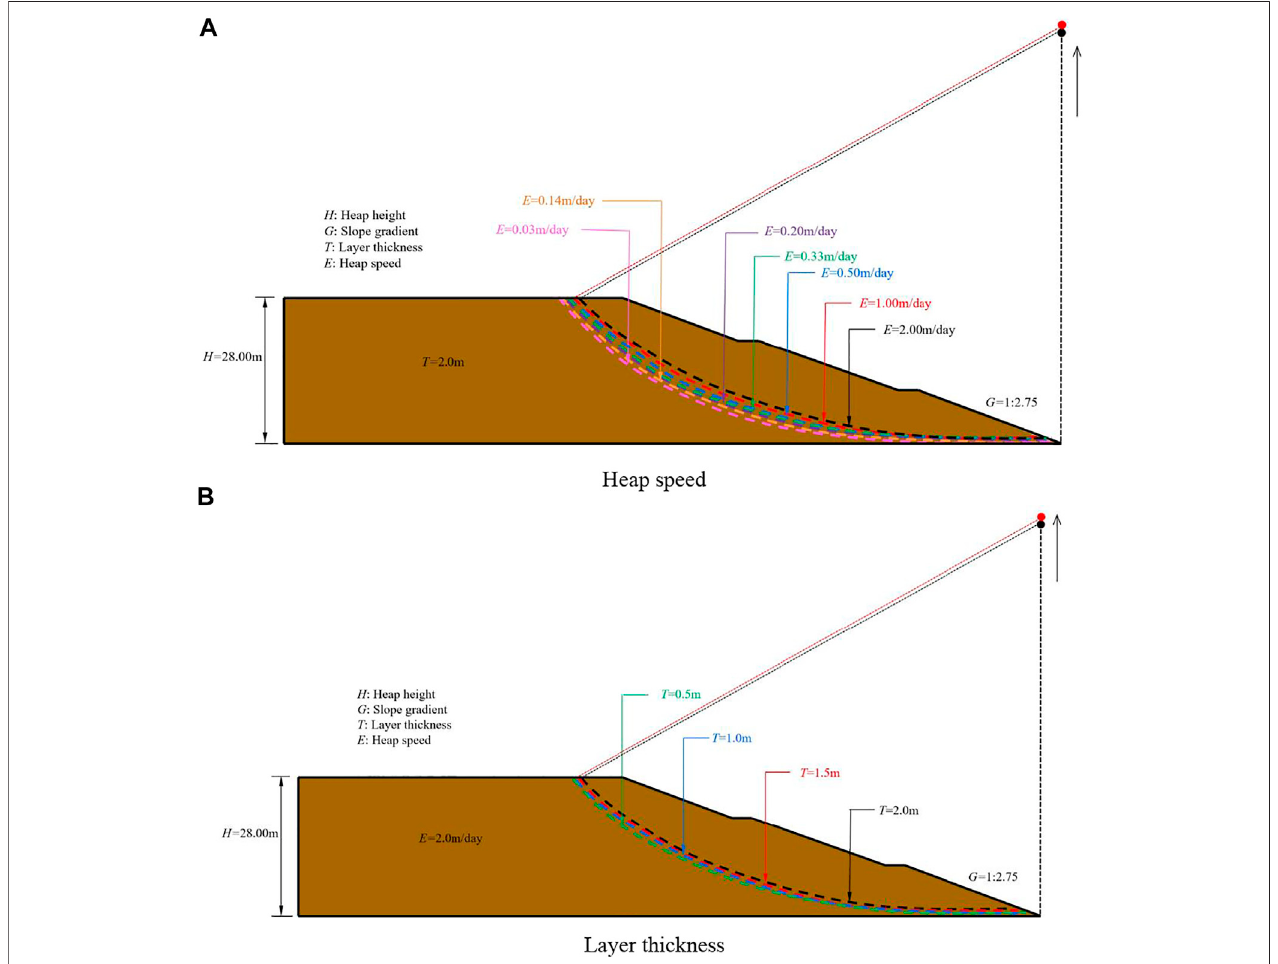
FIGURE 8 | Effect of construction parameters on the location of potential slide surface. (A) Heap speed, (B) layer thickness.